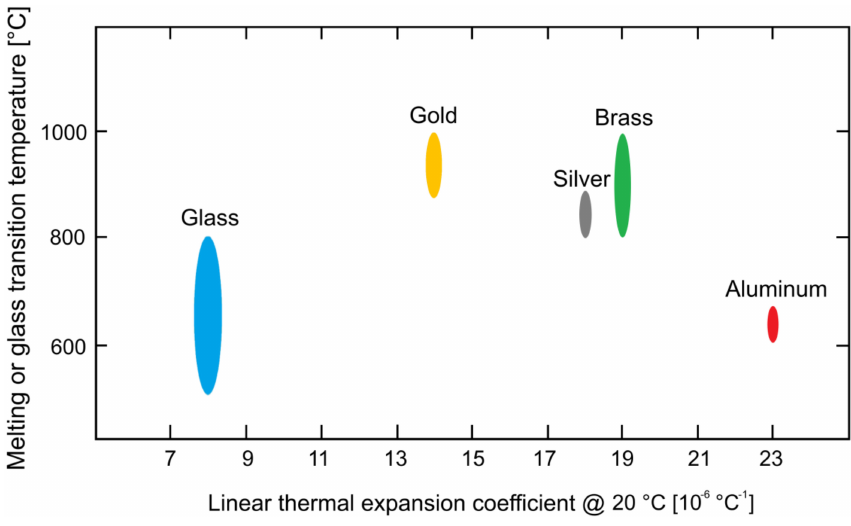
Figure 2. Ashby’s map of the melting point or glass transition temperature vs. linear thermal expansion coe ffi cient of the materials under consideration for the manufacturing of the jewel [39].